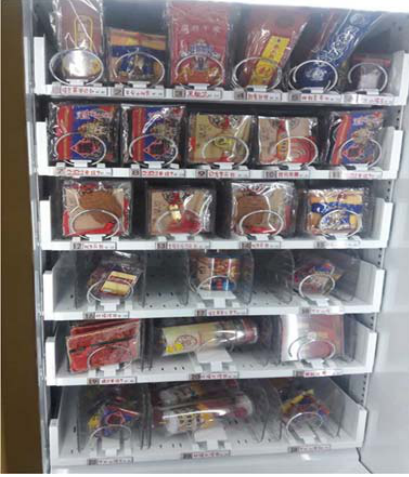
Figure 1. A vending machine with religious ‐ themed creative goods in a Taiwanese temple (Photo from the